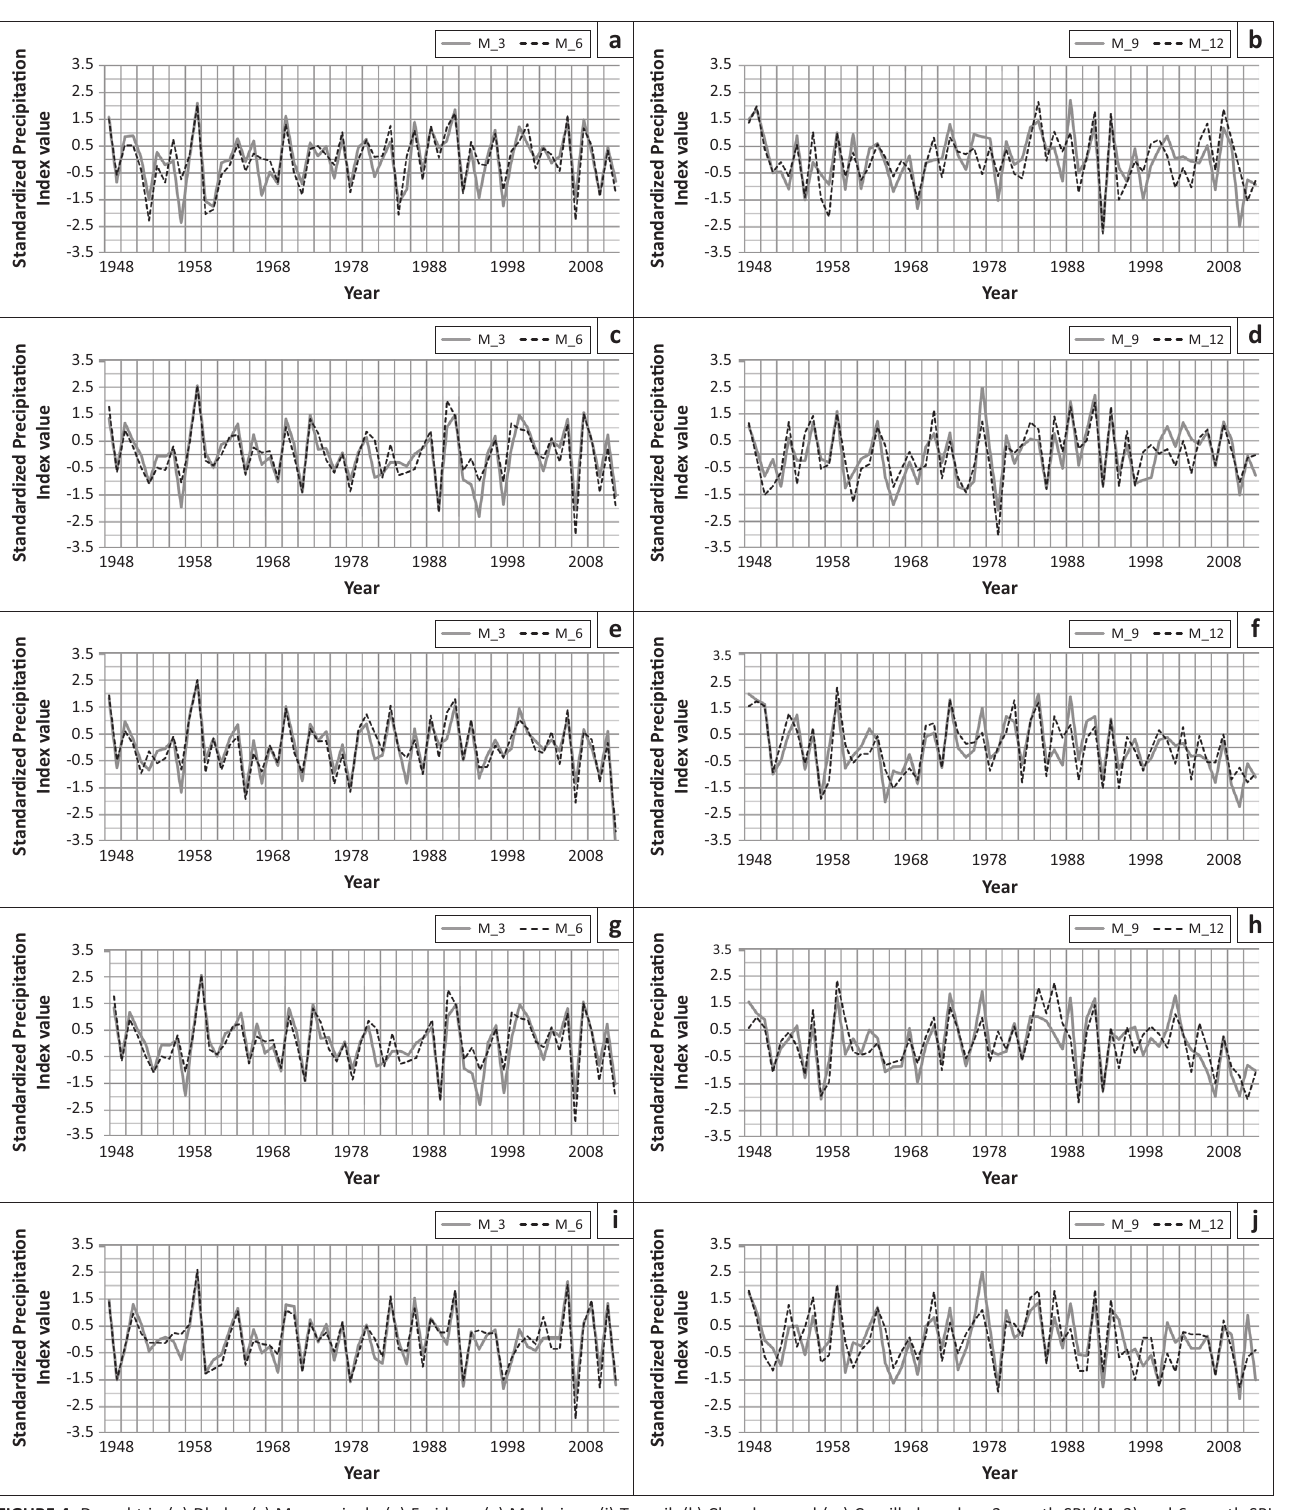
Figure 4 continues on the next page had occurred based on 6-month SPI; 3 extreme droughts, 1 severe drought, 1 moderate drought and 21 normal droughts had occurred based on 9-month SPI and 2 extreme droughts, 1 severe drought, 2 moderate droughts and 20 normal droughts had occurred based on 12-month SPI (Figure 5).